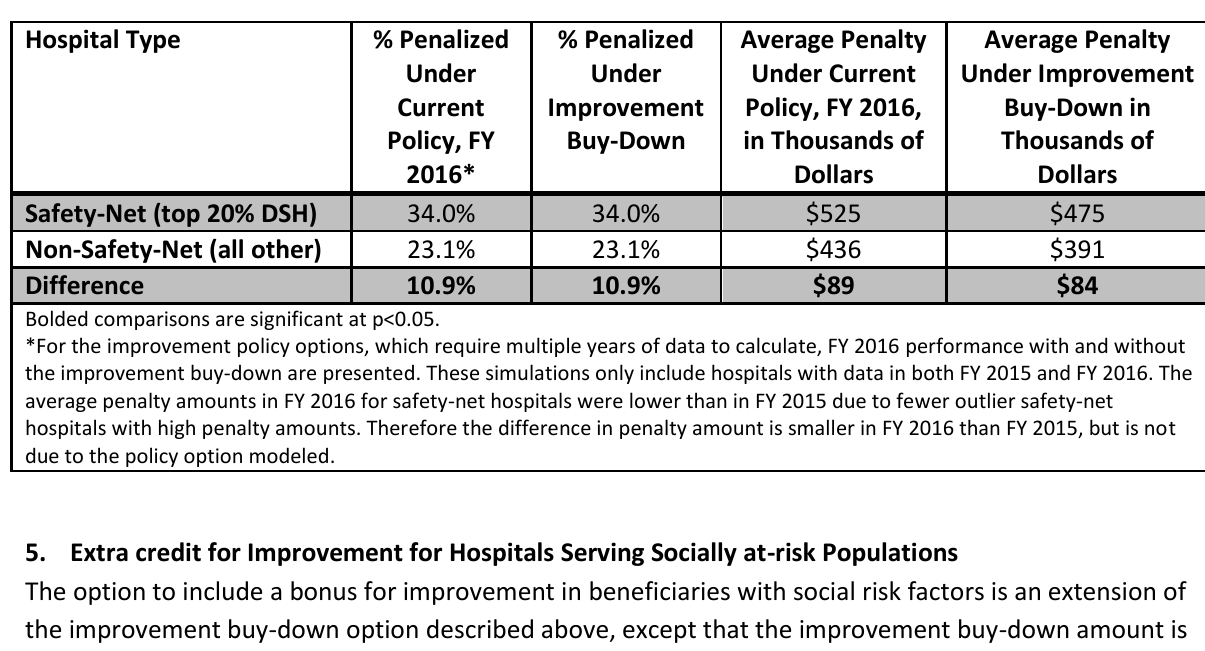
Table 6.18: Percent Penalized and Penalty Amount After Applying Improvement Buy-Down